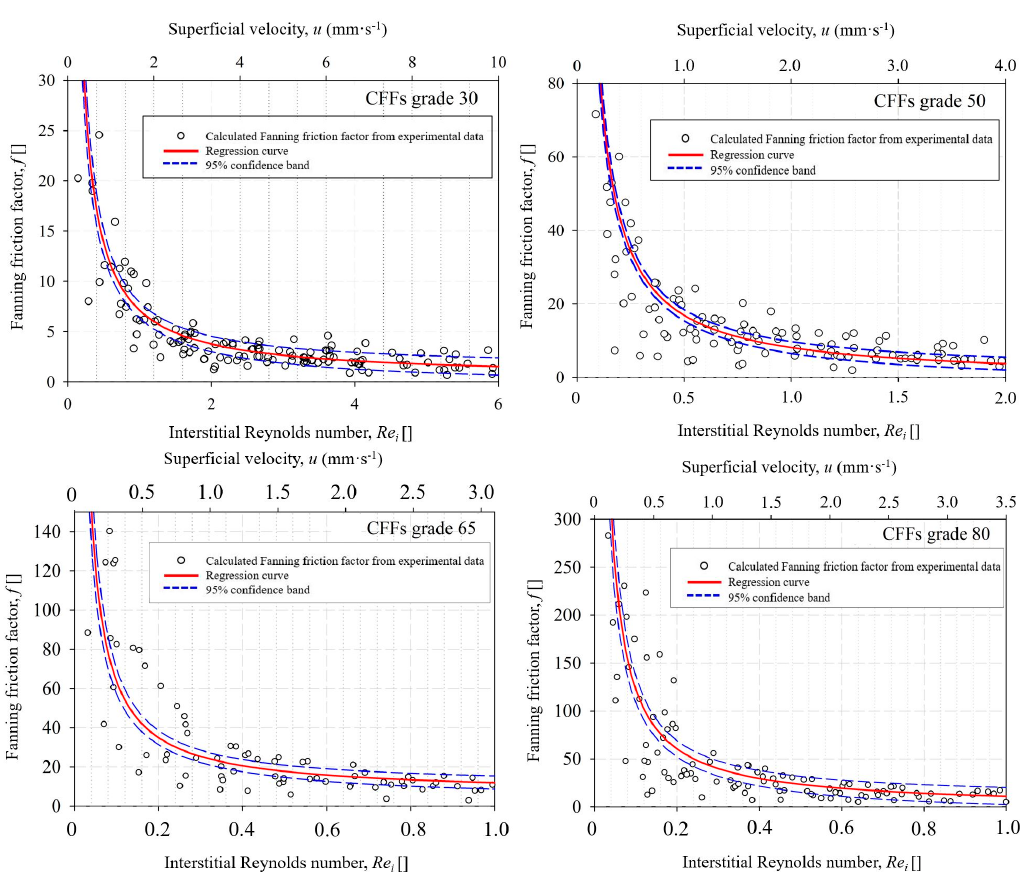
Figure 9. The Fanning friction factor (dimensionless) as a function of the interstitial Reynolds numbers ( Re i ) and superficial velocity ( u ) for CFFs Grade 30–80 from supplier A.